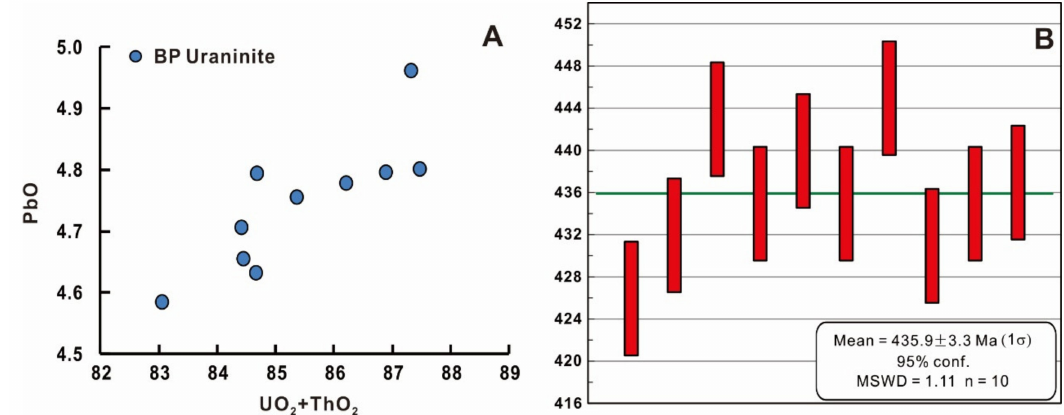
Figure 9. ( A ) PbO vs. UO 2 + ThO 2 shows a positive correlation between the PbO and UO 2 + ThO 2 in BP uraninite. ( B ) Uraninite chemical dating in the weighted average